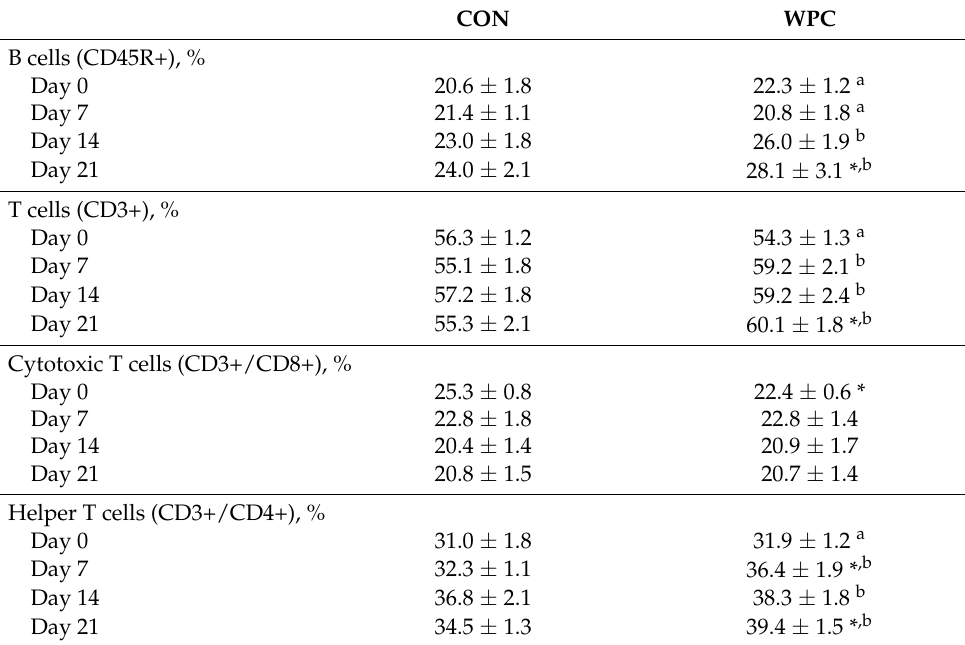
Table 3. Changes in B cell and T cell populations in rats after antigen injection. CON WPC B cells (CD45R+),